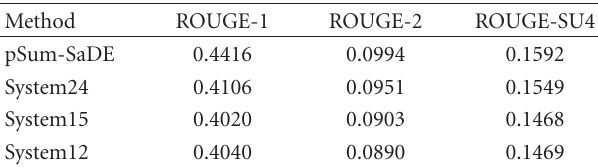
Table 1: ROUGE scores of the methods.